Question: Generate an informative caption for the figure above.
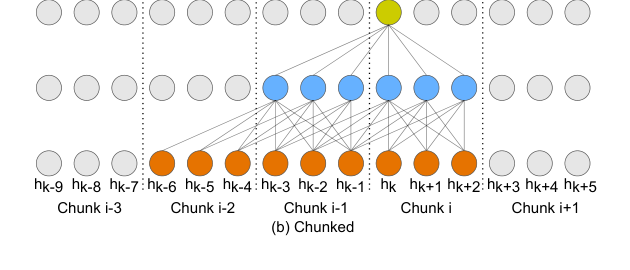
Answer: Diagram of how context gets extended with multi- layer self-attention layers in regular look-ahead vs chunk- aware. Dependency on future frames increases for regular look-ahead in self-attention layers as we go deep in the net- work whereas it remains the same for chunk-aware approach.